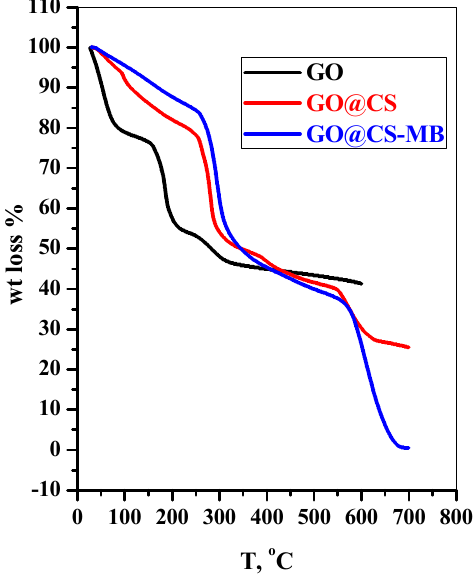
Figure 5. The thermogravimetric analysis (TGA) of GO, GO@CS beads, and GO@CS beads-MB complex.